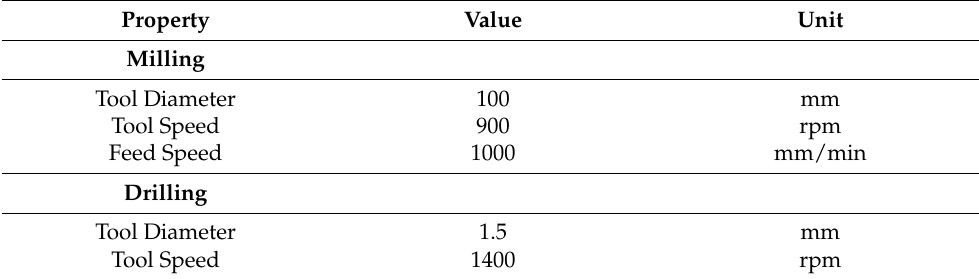
Table 1. Machining parameters.